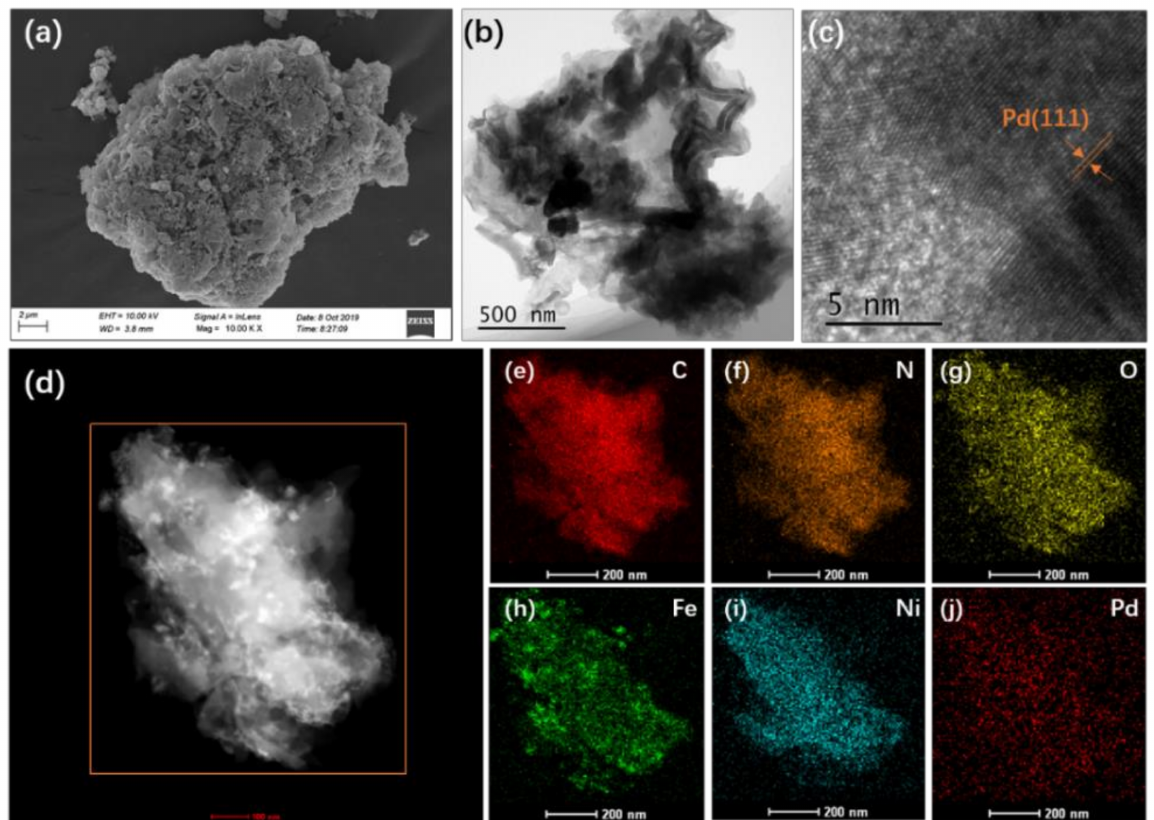
Figure 1. ( a ) SEM image of FeNi-Pd@CN; ( b , c ) HRTEM image of FeNi-Pd@CN; ( d ) HADDF images and ( e – j ) elemental mapping of FeNi-Pd@CN, C, N, O, Fe, Ni, and